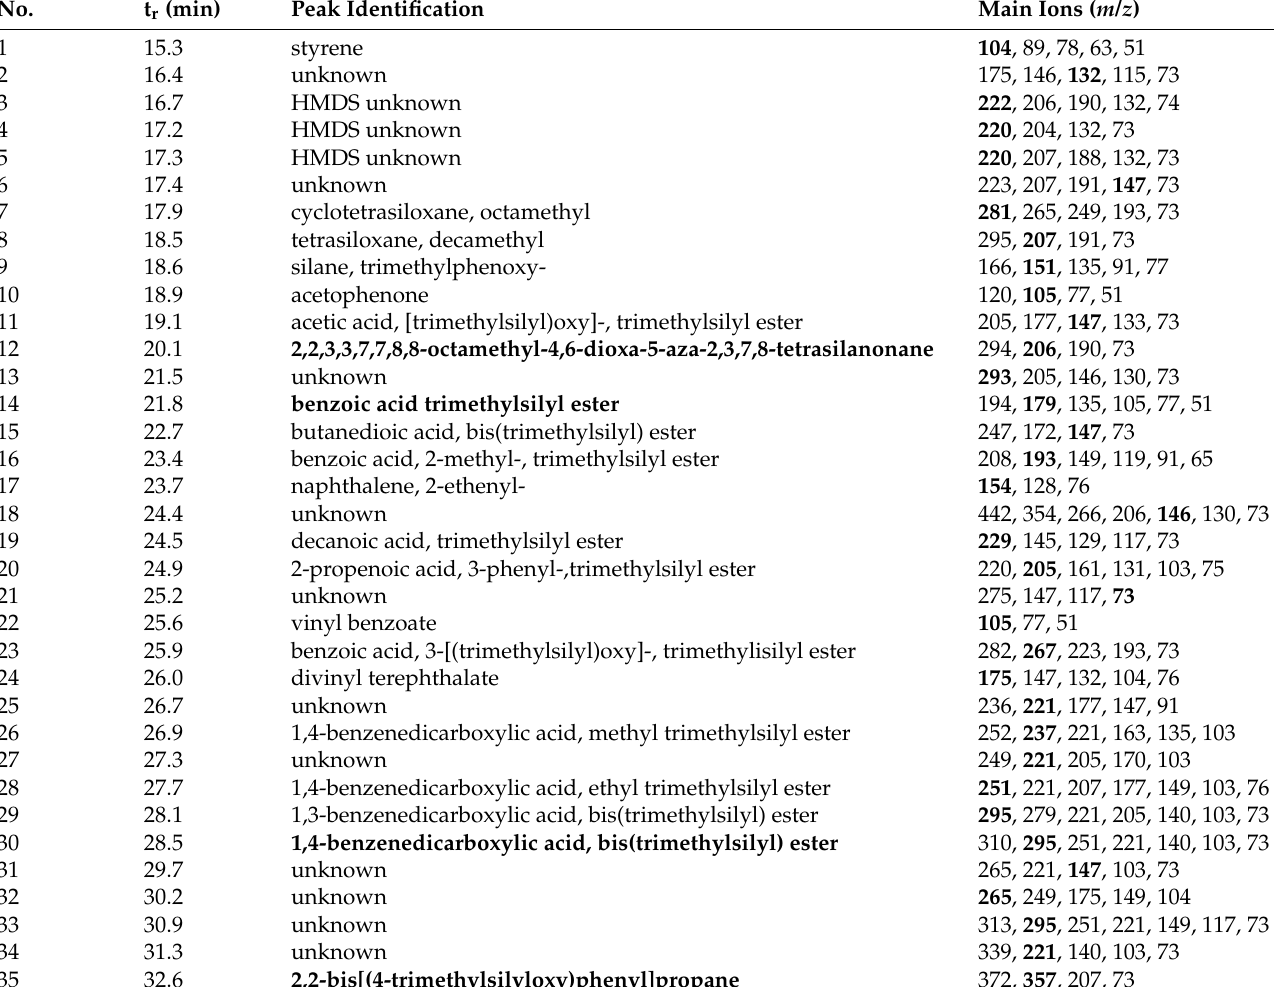
Figure 13. Chromatogram obtained in the Py(HMDS)–GC–MS analysis of the DCM extract of PET-4w. Peak identification is reported in Table 4. Table 4. Identification of peaks in the chromatogram obtained in the Py(HMDS)–GC–MS analysis of the DCM extract of PET-4w (Figure 13). Bold: most abundant species in the chromatogram; most abundant ions in the mass sppectra.